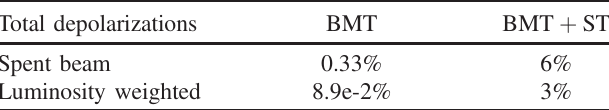
TABLE II. Simulated total depolarizations for CLIC 3 TeV. The beams are assumed to be completely longitudinally polarized before collision.